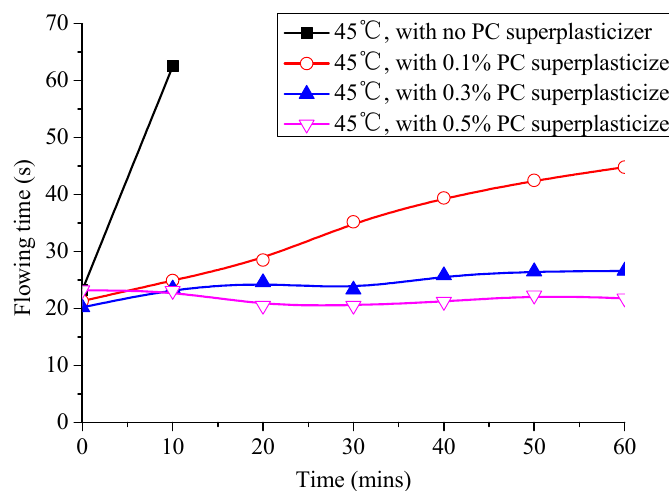
Figure 14. Effect of superplasticizer on the fluidity of CAM I paste.